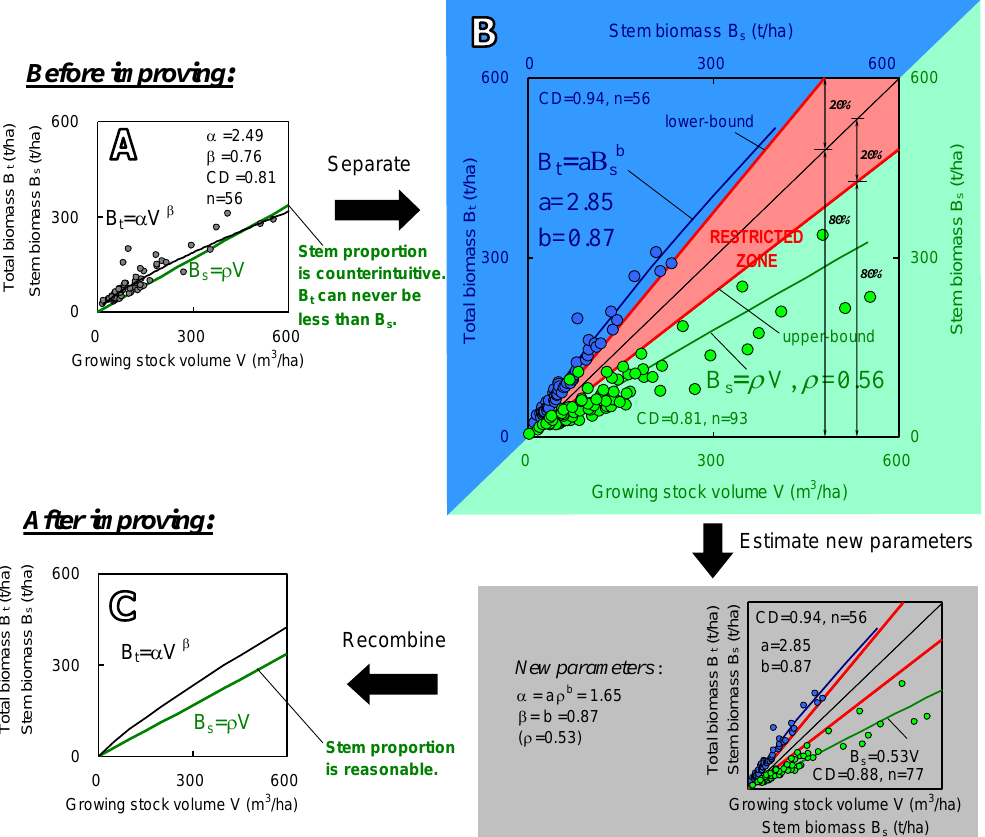
Figure 2. An example ( Eucalyptus and other fast-growing trees in China) of the regression for Equations (1) and (2). ( A ) is the plots and regression with general equation B t = α V β . The green line graphs equation B s = ρ V. ( B ) exhibits two regressions outside the restricted zone separately. The correlation scatters of SABB vs. stem biomass (blue and top left part) and stem biomass vs. stem volume (green and bottom right part). The top left parts illustrate the regression for Equation (1), and bottom right parts do this for Equation (2). A restricted zone is designed ranging from the lower-bound of B t (shows a proportion as 80% stem and 20% other parts of the tree) to upper-bound of B s (shows maximum wood density of 0.7). The samples of B s vs. B t are less than the ones of B s vs. V, because some plots were not measured for roots. ( C ) shows the recombined equation using the slope ρ after data cleaning.